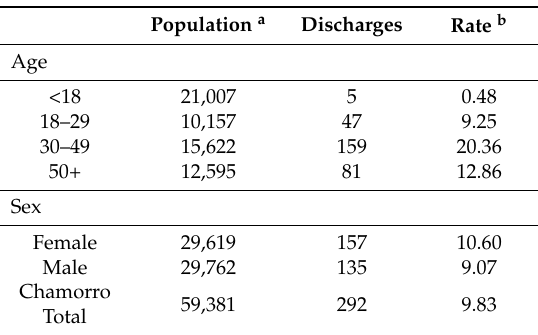
Table 2. Incidence of first-mentioned discharge for urolithiasis by age and sex among patients identifying as Chamorros, Guam Memorial Hospital, 2006–2010.